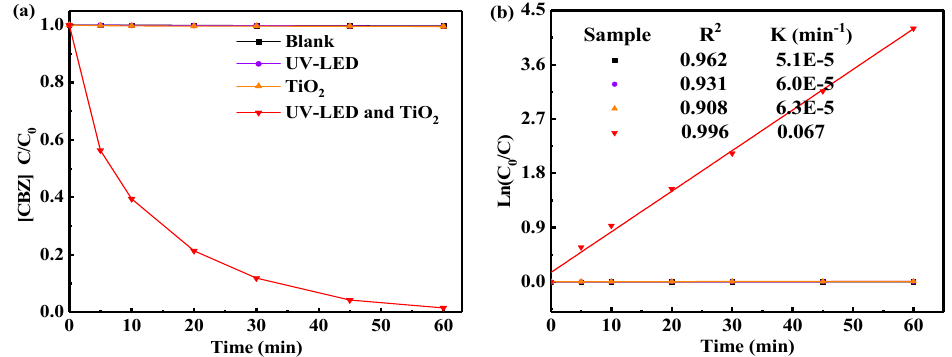
Figure 2. ( a ) CBZ degradation control experiments ( b ) The pseudo-first-order kinetic models of CBZ degradation . C(CBZ) 0 = 18.8 µM; operating temperature = 20 °C; wavelength of UV-LED = 365 nm; I 0 = 774 µW/cm 2 ; and operating pH = 7.6.